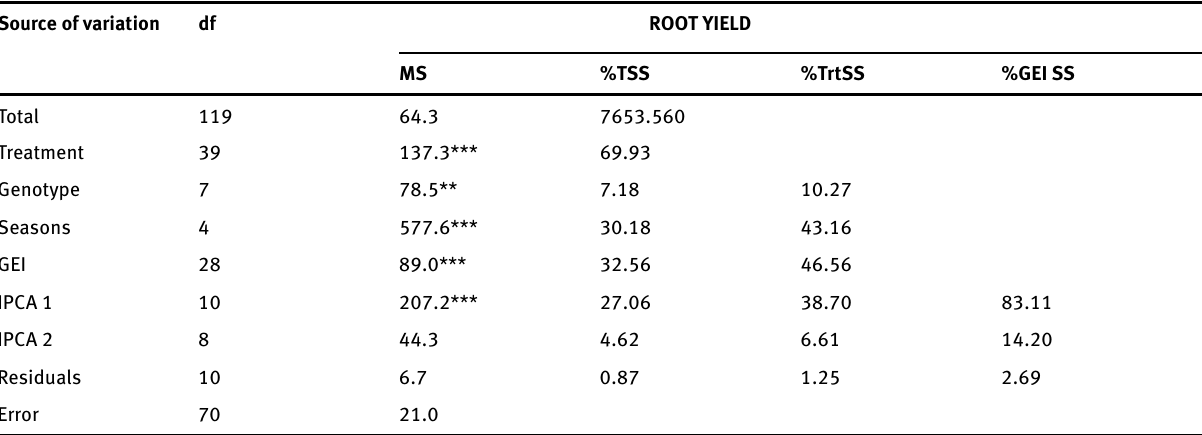
Table 1: Summary of AMMI analyses for sweetpotato root yield Source of variation df ROOT YIELD